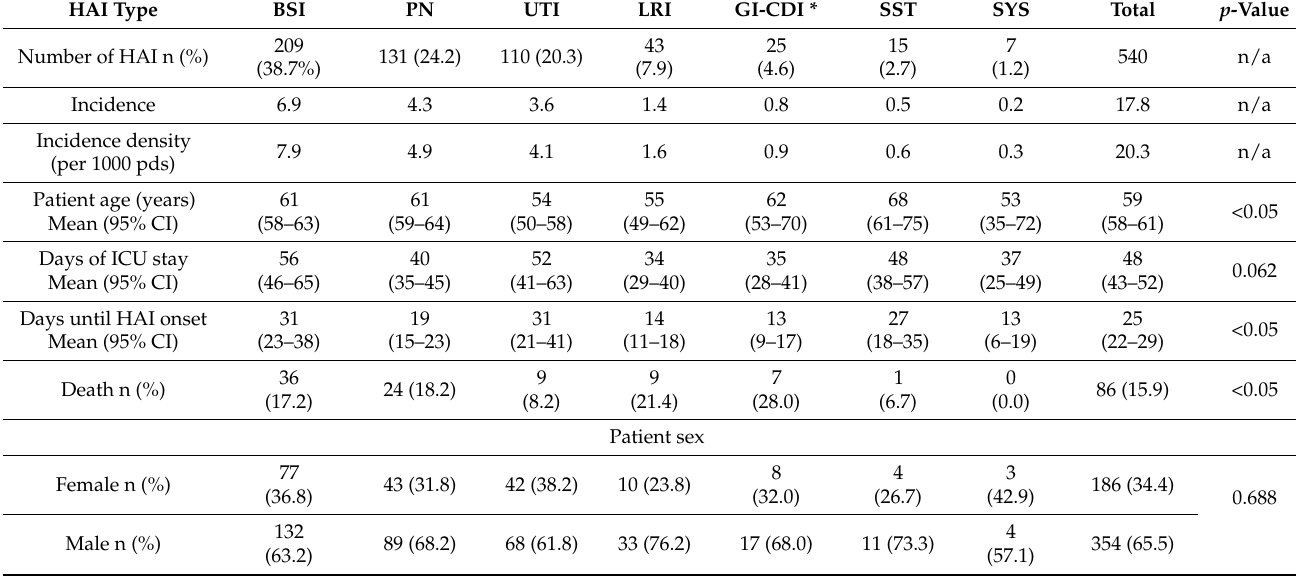
Number of patients = 3028, Number of patient-days of stay = 26,558, Clostridioides difficile (CDI) 25 cases *(CDI/100 admissions = 0.8; CDI/1000 = 0.9; CDI/10,000 = 9.4), 95%CI—95% confidence intervals for the mean, number (n), not applicable (n/a), healthcare-associated infections (HAI), bloodstream infection (BSI), pneumonia (PN), urinary tract infection (UTI), lower respiratory tract infection (LRI), gastrointestinal infection (GI) Clostridioides difficile infection (CDI), skin and soft tissue (SST), systemic infection (SYS). The specified forms of HAIs were analysed through the assessment of patients’ sex, age, average length of stay in the ICU and the onset of infection, duration of infection treatment and mortality. The lowest average age, 53 years, was recorded for SYS infections, and the highest, 68 years, for SST. The effect of the time elapsed from admission into ICU to the onset of HAI was visible. SYS, PN, LRI, and GI-CDI infections appeared less than three weeks after admission, on average, while BSI and UTI developed, on average, after a month ( p < 0.05). When analysing patient deaths, a large variation concerning individual forms of HAI was observed; infections revealing the greatest mortality were GI 7 (28%), followed by LRI 21 (21.4%), PN 24 (18.2%), BSI 36 (17.2%), UTI 9 (8.2%), and SST 1 (6.7%) ( p < 0.05). Men dominated among the patients treated ( p = 0.688) (Table 1).